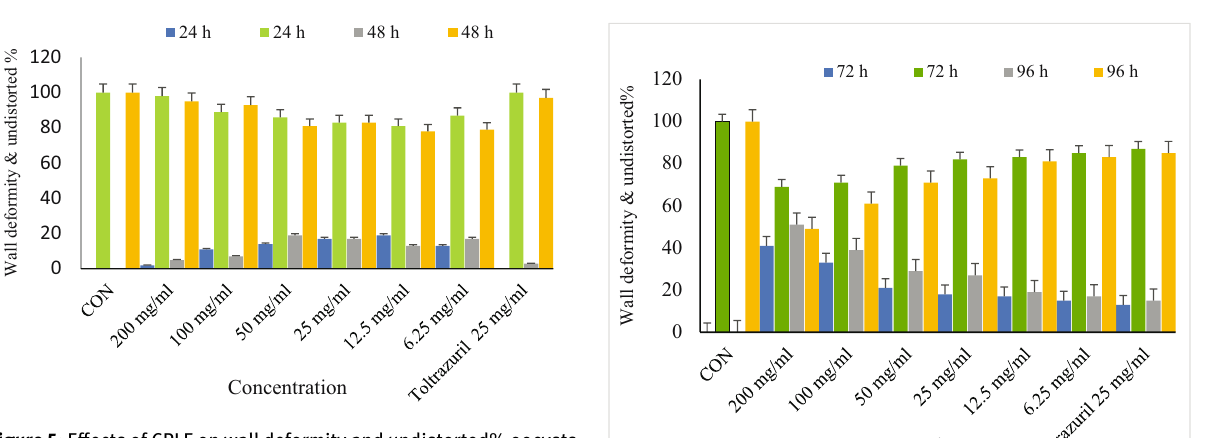
Figure 5: E ff ects of CPLE on wall deformity and undistorted% oocysts of E. papillata at di ff erent concentrations at 24 and 48 h in vitro . The signi fi cance was compared to potassium dichromate 2.5% as a Figure 6.: E ff ects of CPLE on wall deformity and undistorted% negative control and Toltrazuril 25 mg/mL as a positive control. oocysts of E. papillata at di ff erent concentrations at 72 and 96 h in Signi fi cance in comparison to the control group ( p < 0.05 ) . vitro . The signi fi cance was compared to potassium dichromate 2.5% as a negative control and Toltrazuril 25 mg/mL as a positive control. ) but not with Toltrazuril 25mg/mL. Signi fi cance in comparison to the control group ( p < 0.05 ) . control groups ( K Cr O 2 2 7 Most concentrations include anti - sporozoite activities against E. papillata at 50, 100, and 200 mg/mL. The highest viability inhibitory percentage was 91% at a concentration of 200 mg/mL of CPLE against the E. papillata strain. The lowest e ffi cacy against E. papillata was 11% at a concen - tration of 6.25 mg/mL after 24 h.